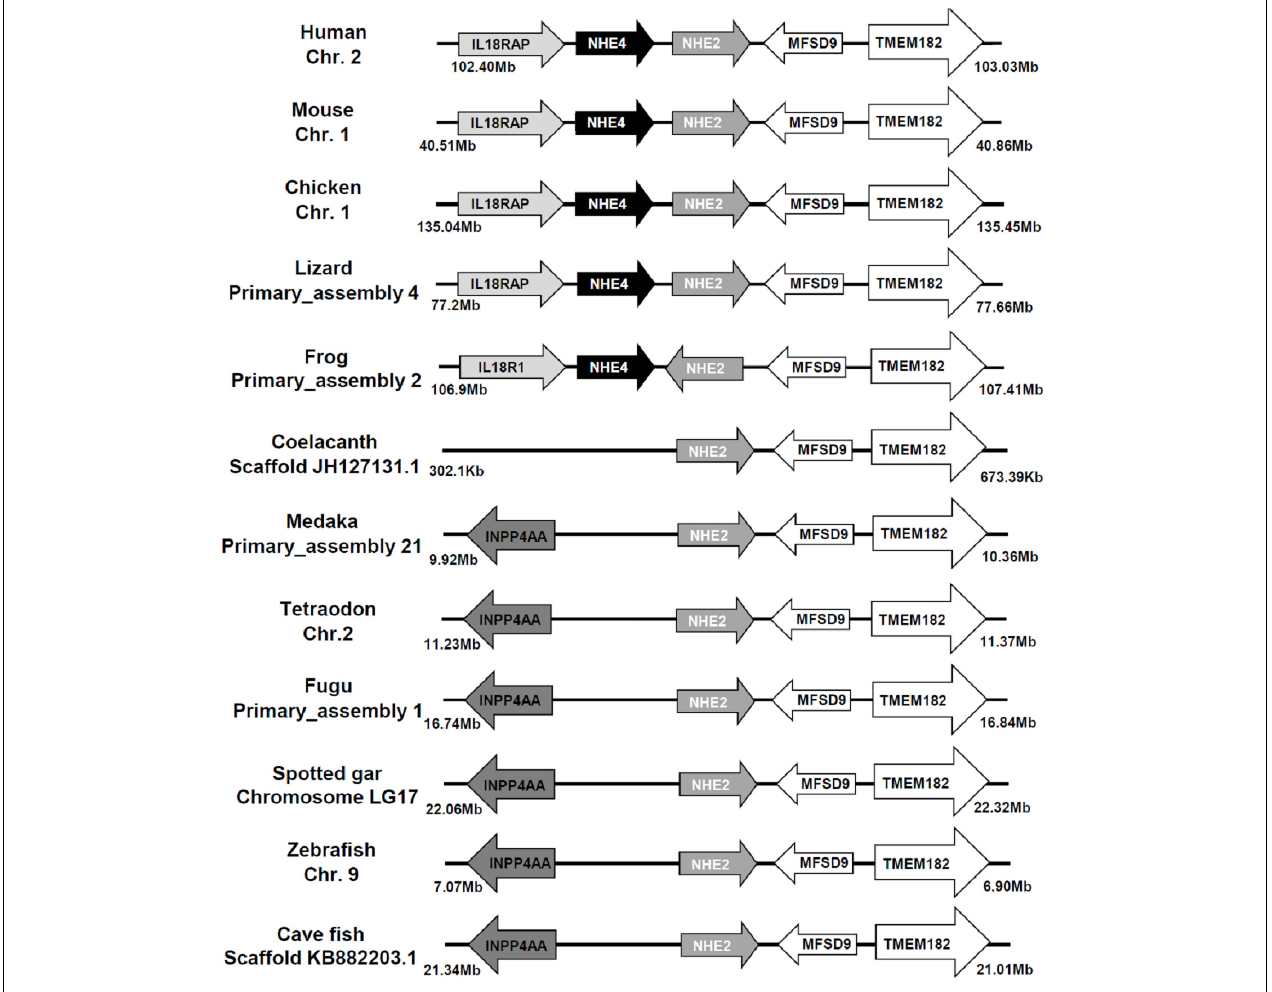
FIGURE 2 | Gene structures of Na + /H + exchanger 2 (NHE2) and NHE4 orthologs. The distance of the genomic region is presented on both sides. The arrow indicates the direction of the gene. Both NHE2 and NHE4 orthologs and their neighboring transcripts were obtained from NCBI and Ensembl databases (as described in Supplementary Table 1 ). Chr., chromosome; IL18RAP (IL18R1), interleukin-18 receptor accessory protein; INPP4AA, inositol polyphosphate-4-phosphatase type I; MFSD9, major facilitator superfamily domain containing 9; TMEM182, transmembrane protein